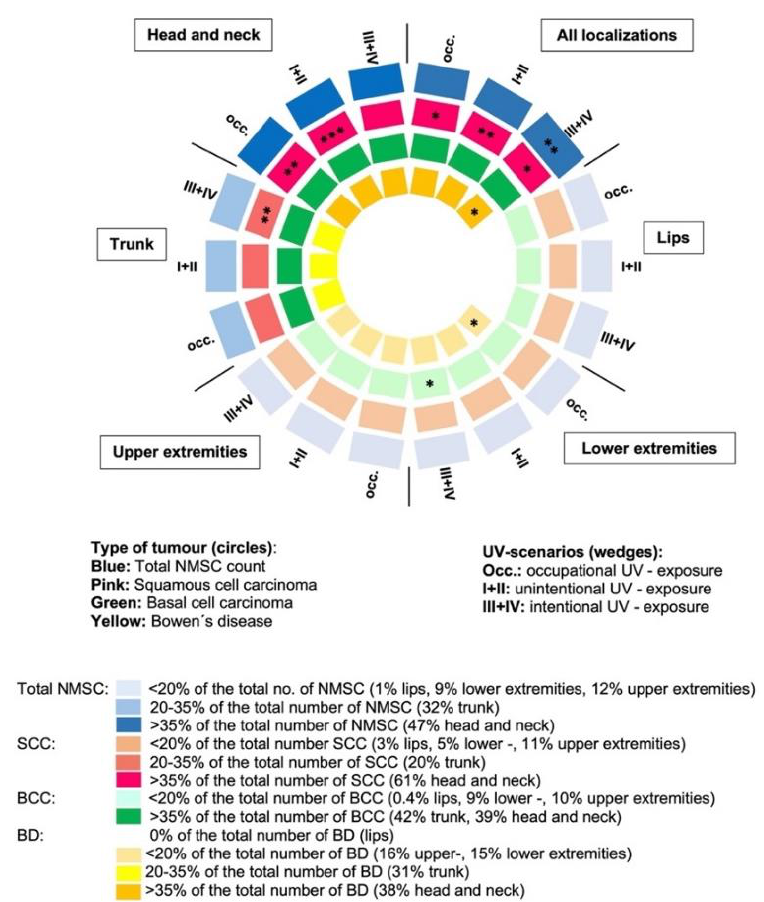
Figure 3. Correlations between UV exposure, localization, and number of NMSCs. NMSC types are shown as colored circles and the percentage of NMSCs as colored wedges, with the intensity of the colors corresponding to the percentage of the total number of each tumor. Significant p values are indicated by asterisks, *: p < 0.05, **: p < 0.01, ***: p < 0.001. Table 3. Total hours of UV exposure in different UV scenarios in subgroups of cases.